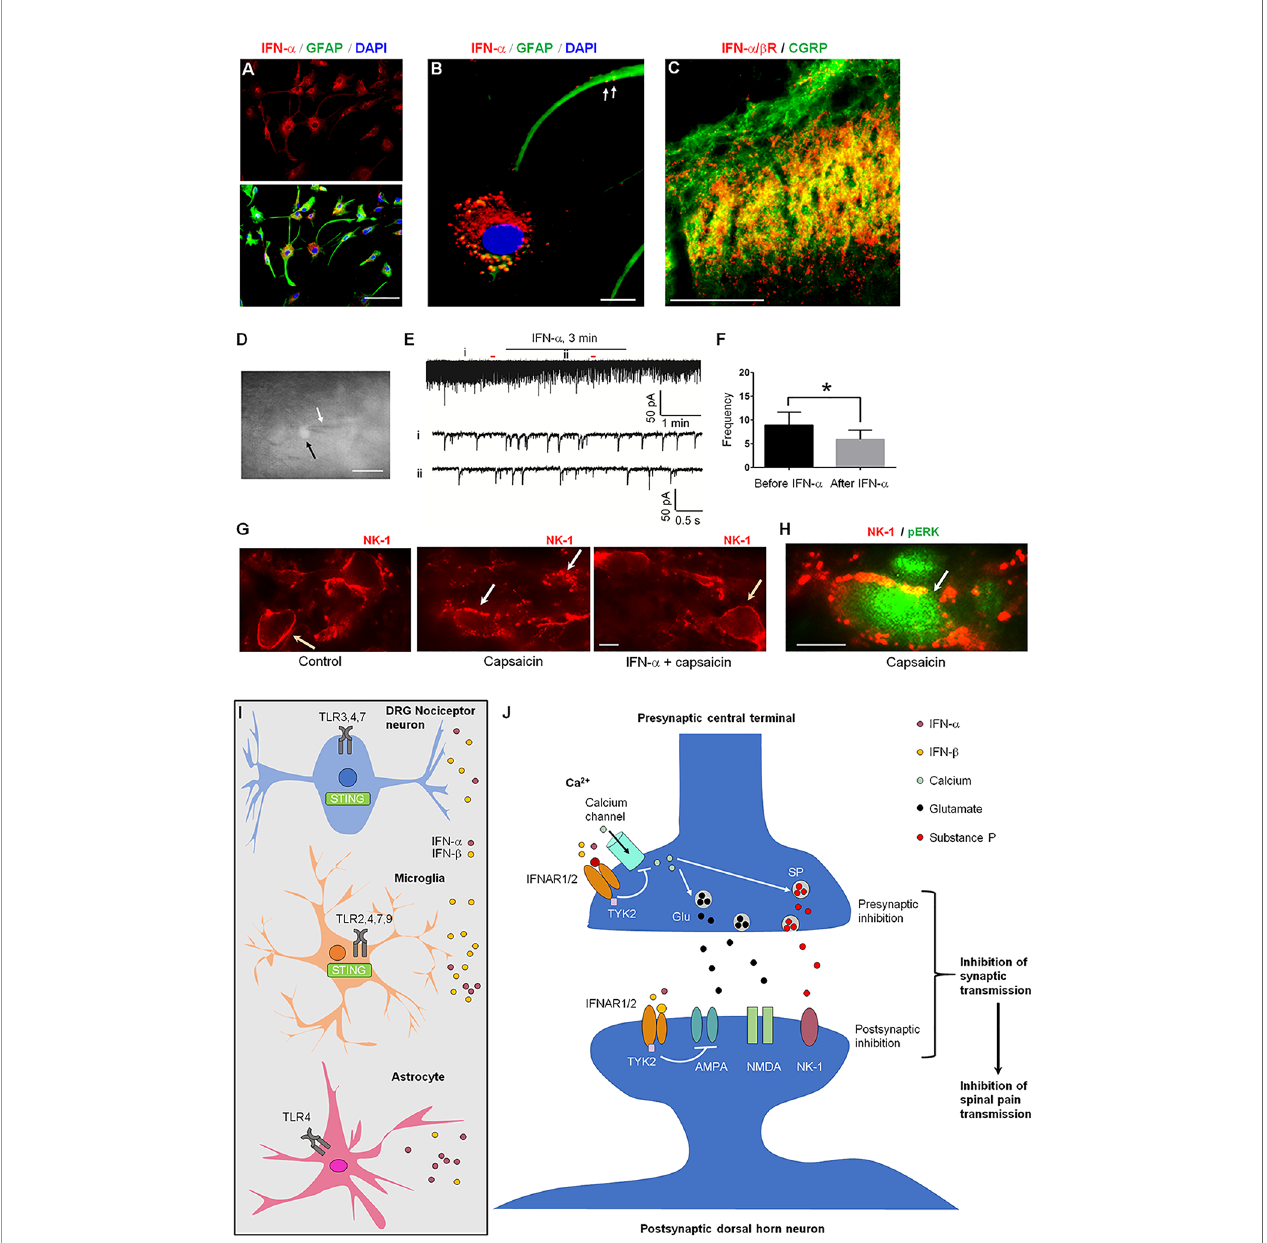
FIGURE 4 | IFNAR signaling in the spinal cord for the inhibition of nociception. (A) IFN- a expression in cultured astrocytes. (B) Triple staining of IFN- a , GFAP, and nuclei marker DAPI in cultured astrocytes prepared from cerebral cortexes of neonatal Sprague-Dawley rats. Scales, 50 m m in A and 10 m m in B. Arrows indicate IFN- a -labeled vesicles in remote astrocyte processes. (C) Double staining of IFNAR (IFN- a / b R) and CGRP in the super fi cial dorsal horn. Scale, 100 m m. (D – F) IFN- a inhibits synaptic transmission in spinal cord slices. (D) The recorded neuron (somatostatin-positive, shown by white arrow) with an electrode (black arrow). (E) Patch clamp recording reveals an inhibition of spontaneous excitatory postsynaptic currents (sEPSCs) in lamina II neurons by IFN- a (25 ng/ml, 2 min). i and ii indicate traces before and after the treatment. (F) Frequency (Hz) of sEPSCs. 7 out of 9 recorded neurons respond to IFN- a . *P<0.05, n = 7 neurons. (G, H) IFN- a suppresses spinal nociceptive transmission. (G) Intraplantar capsaicin-evoked NK-1 internalization in super fi cial dorsal horn neurons is suppressed by intrathecal IFN- a (100 ng). The slices were stimulated with capsaicin (3 mM, 5 min) or pretreated with IFN- a 10 min before capsaicin stimulation. Orange and white arrows indicate surface-expressed and internalized NK-1 receptors, respectively. (H) Double staining showing co-localization of NK-1 (with internalization) and ERK phosphorylation (pERK) in a lamina I neuron (arrow) following capsaicin stimulation. Scales, 10 m m. A-H are reproduced from (50) with permission. (I, J) Type-I IFN and IFNAR signaling mediates neuro-glial interactions in the spinal cord for pain modulation. (I) IFN- a and IFN- b are produced by astrocytes, microglia, and nociceptive neurons following stimulation of TLRs and STING. (J) Activation of IFNAR inhibits nociception via both pre-synaptic and post-synaptic mechanisms. At the presynaptic sites, IFNAR activation inhibits calcium channels and neurotransmitter release. At the post-synaptic sites, IFNAR activation inhibits the activity of the glutamate AMPA